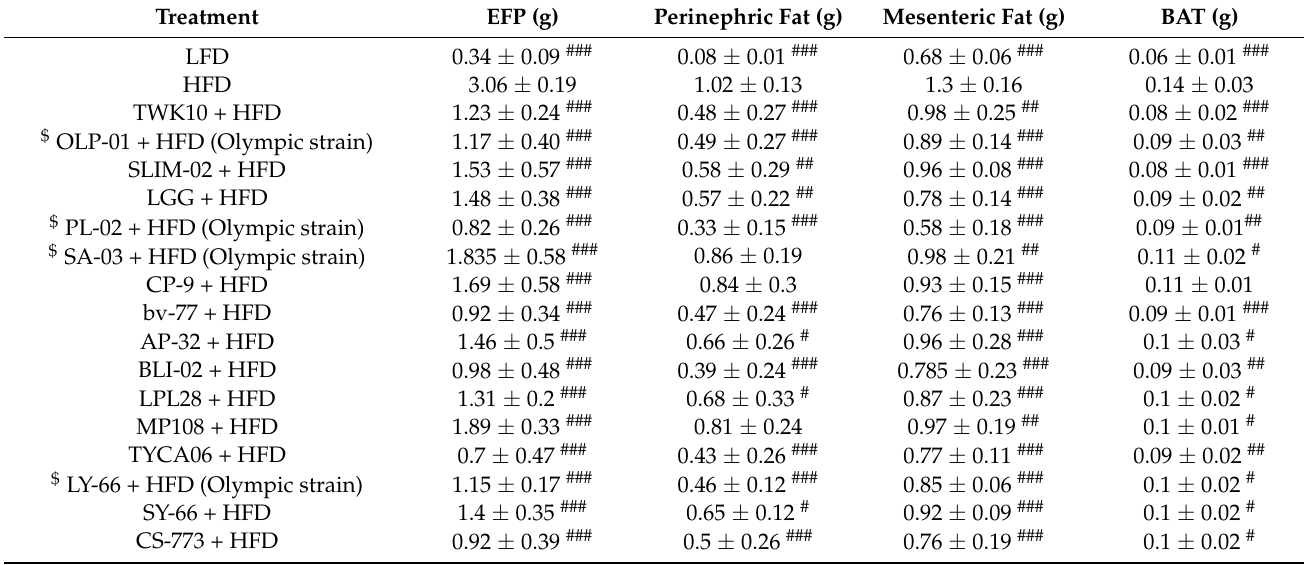
Table 2. Effect of probiotic supplementation on adipose tissue